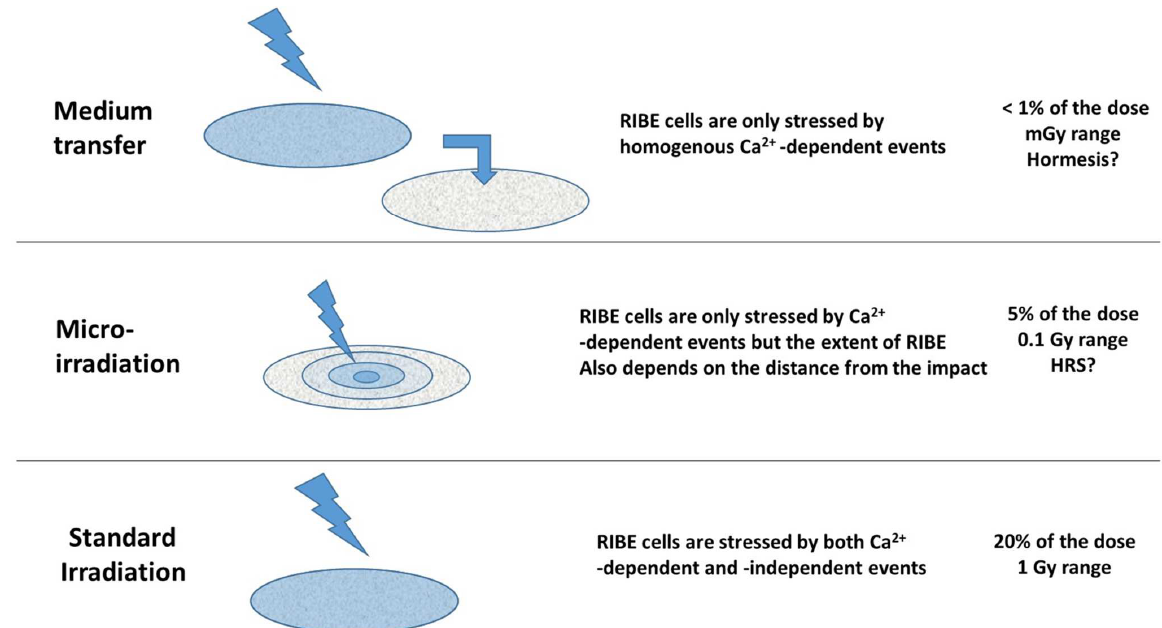
Figure 10. Schematic summary of the RIBE according to the irradiation protocol. For medium transfer, micro-irradiation and “standard” irradiation, all or a subset of cells are concerned by calcium-dependent events leading to RIBE DSB. For each protocol, the calcium-dependent events contribute differentially to the total dose and some specific radiobiological phenomena may occur (hormesis or HRS).